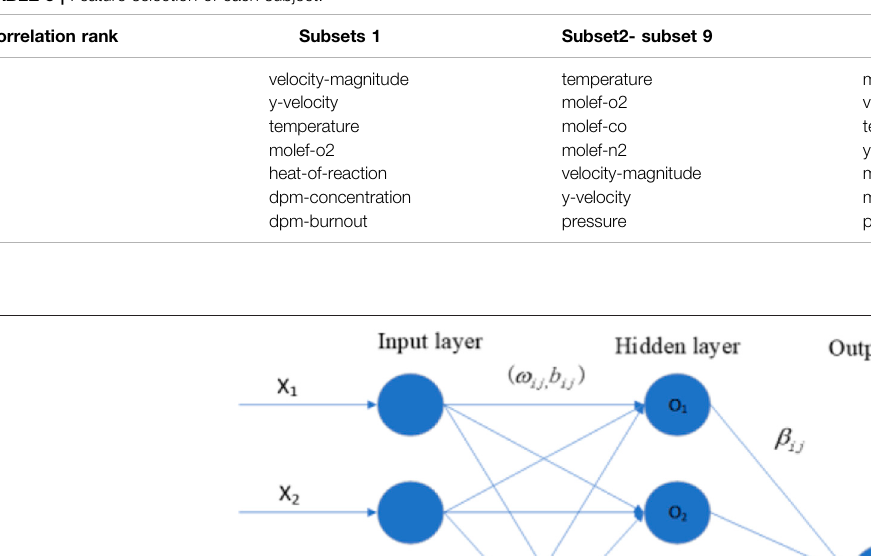
TABLE 5 | Feature selection of each subject.